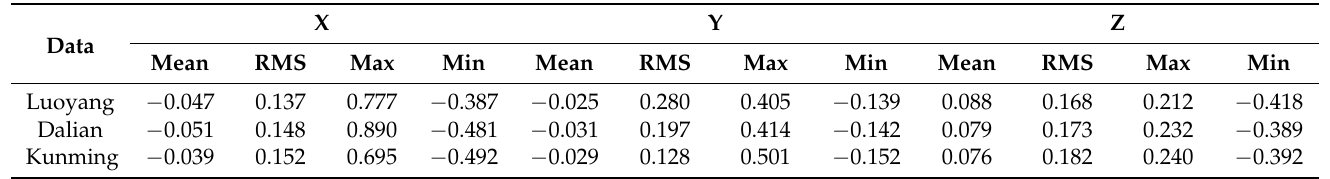
Table 16. Ground coordinates differences statistics based on calibrated alignment angles and pointing angle files. (Unit: meter).